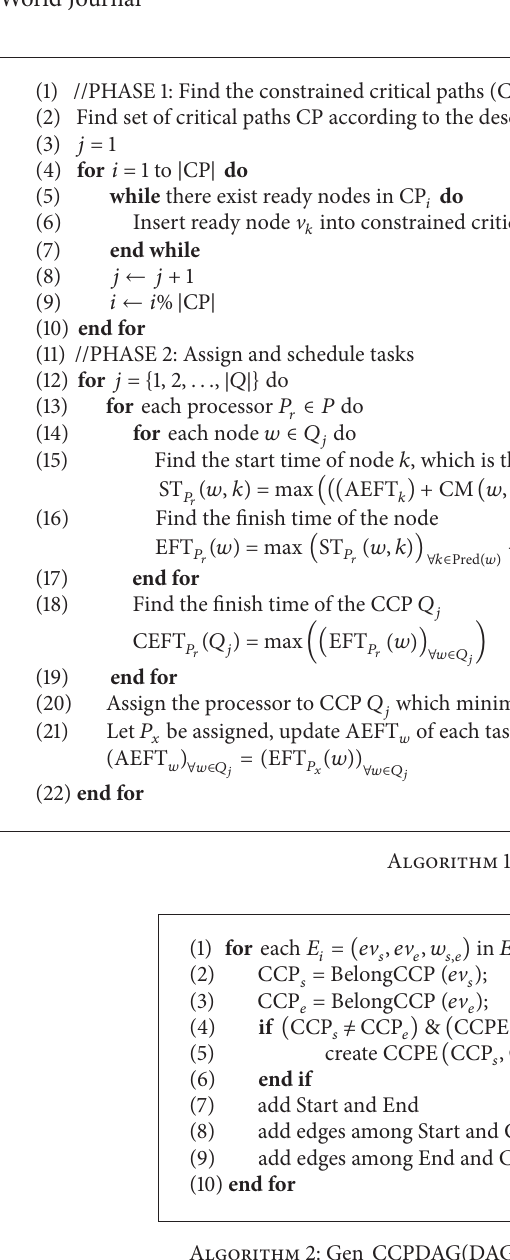
Algorithm 2: Gen CCPDAG(DAG, CCP) generating